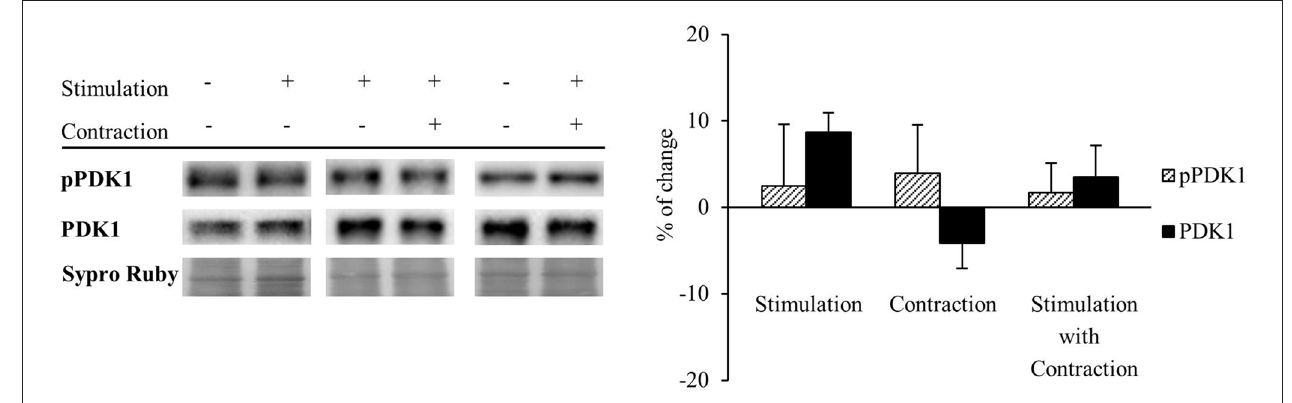
FIGURE 3 | Total PDK1 levels and its phosphorylation are unaltered after synaptic activity and muscle contraction. PDK1 and pPDK1 in presynaptic stimulation treatment, Contraction treatment and Presynaptic stimulation with contraction treatment at 1 Hz stimulation for 30 min. Presynaptic stimulation has been simplified as Stimulation . Each column has been compared to its respective control (see Table 1 ). Results showed that PDK1 and pPDK1 levels, as well as pPDK1/PDK1 ratio, remained unaltered after nerve stimulation with and without muscle contraction. Data are mean percentage ± SEM, (Stimulation n = 7, Contraction n = 6 and Stimulation with Contraction n = 6). Abbreviations: PDK1, phosphoinositide-dependent kinase 1; pPDK1, phosphorylated phosphoinositide-dependent kinase 1.